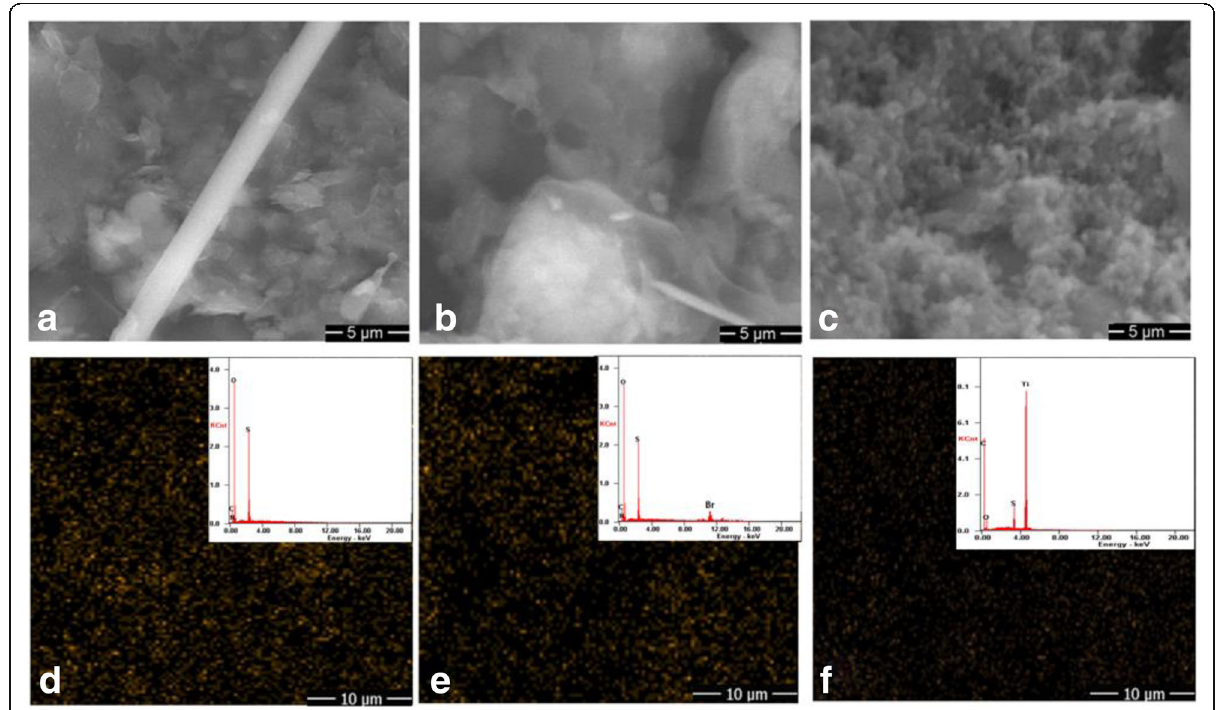
Fig. 7 SEM images of the surface view of a PDAAQ/PC-FCF b PDAAQ/PC-FCF/CTAB c PC-FGF/TiO 2 /MWCNT coated separators cycled for 100 cycles at 0.5 C with TiO 2 /PC-FGF/S cathode, EDS mapping of sulfur element on the separator surface cycled d with PDAAQ/PC-FCF e PDAAQ/PC- FCF/CTAB, and f PC-FGF/TiO 2 /MWCNT-coated separators with TiO 2 /PC-FGF/S cathode; the insets are the related elemental